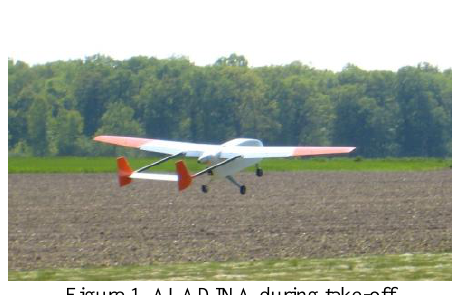
Figure 1. ALADINA during